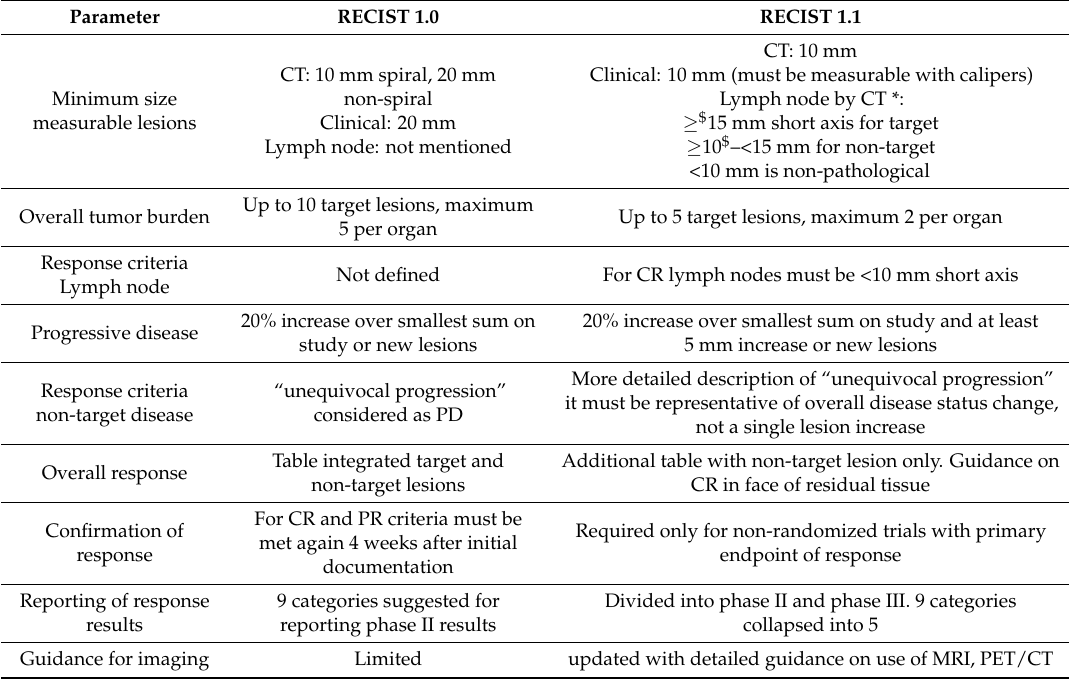
Table 2. Summary of major changes RECIST 1.0 to RECIST